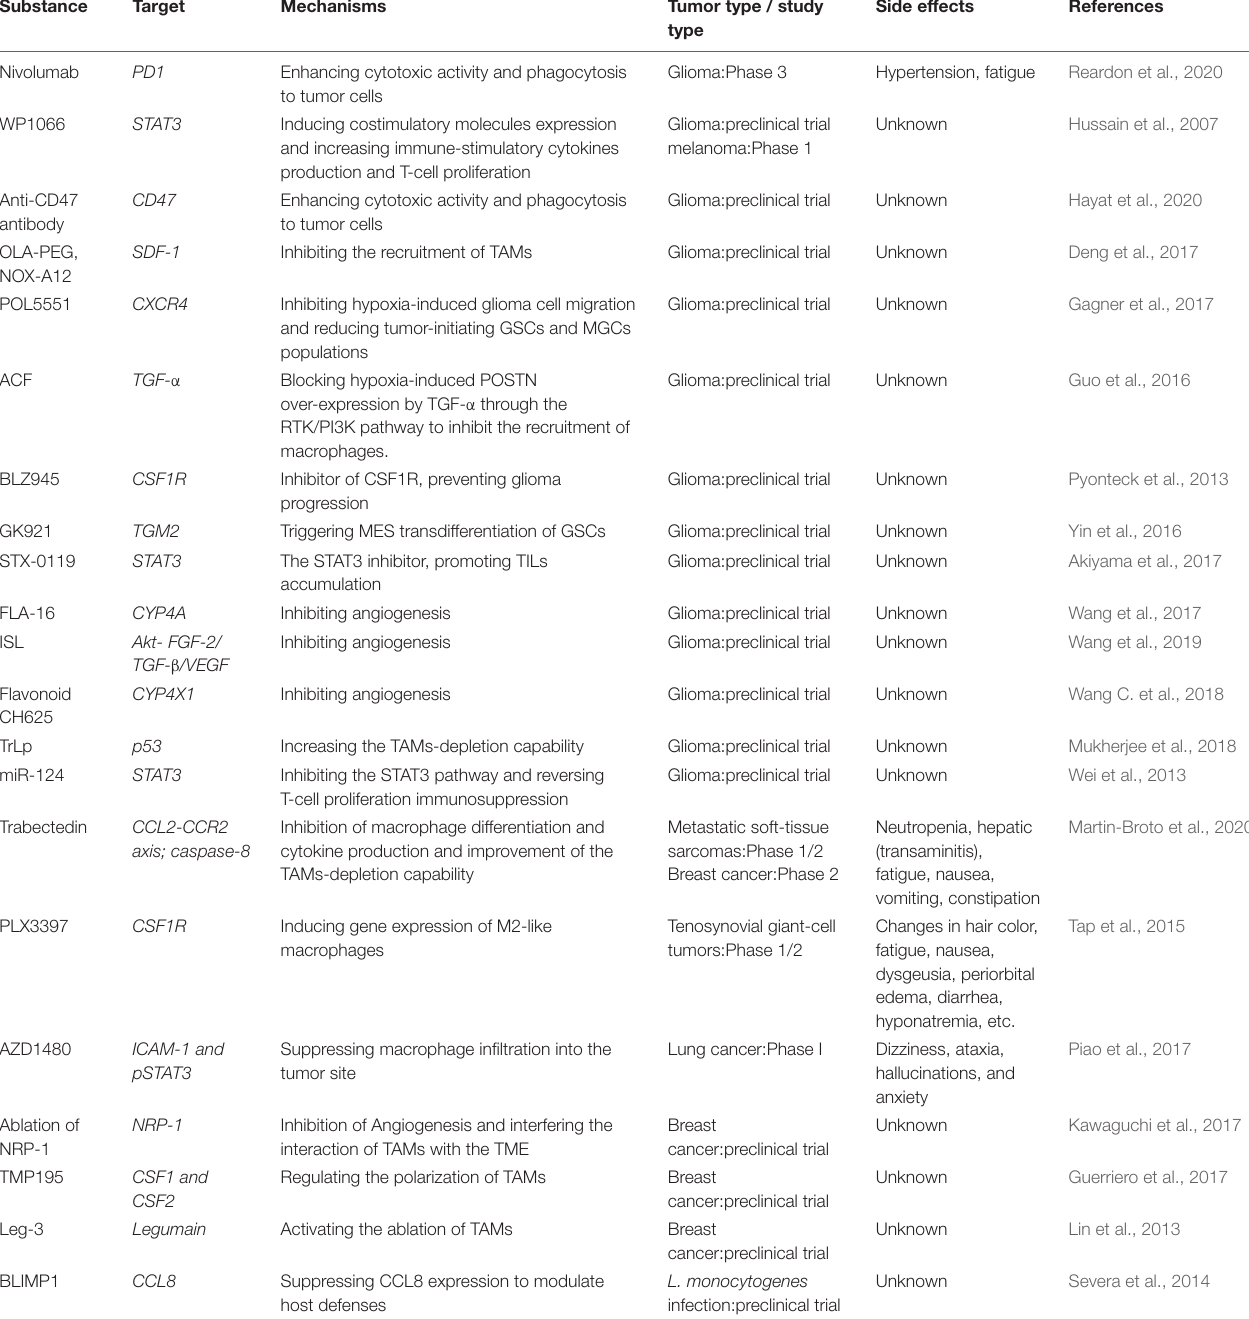
TABLE 1 | Macrophages targeting therapies in